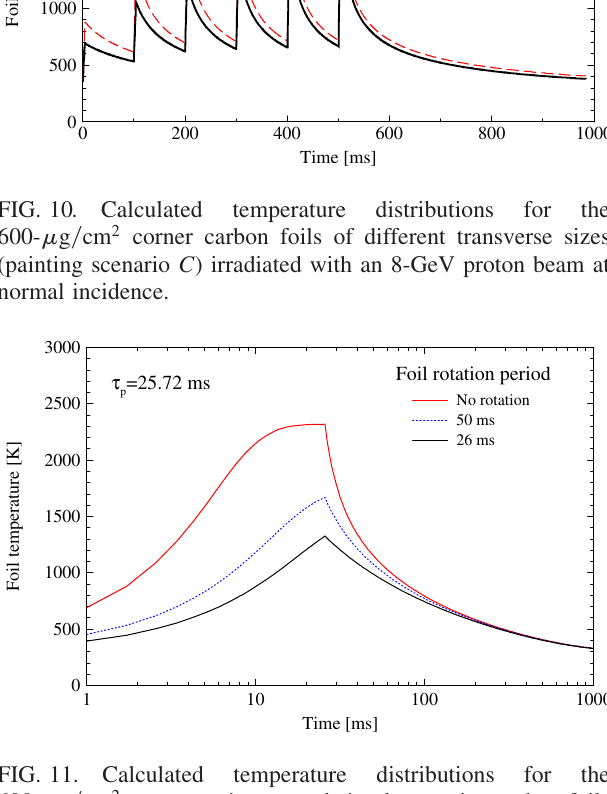
FIG. 11. Calculated temperature distributions for the 600 - (cid:3) g = cm 2 corner stationary and circular rotating carbon foils (painting scenario D ) irradiated with an 8-GeV proton beam at normal